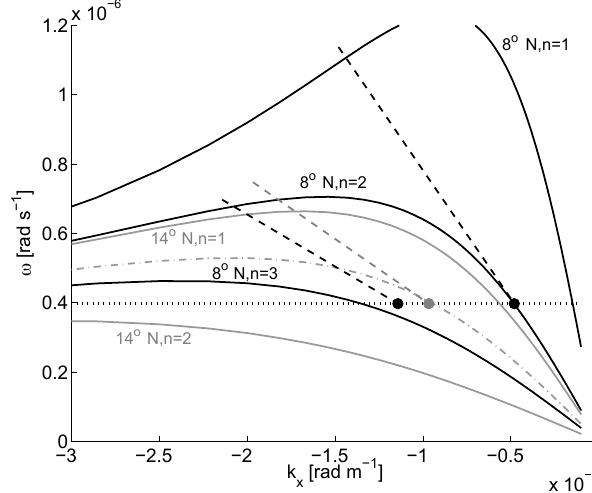
Figure 14. Wavenumber–frequency dispersion diagram for baro- clinic Rossby waves corresponding to values of the deformation radius equal to 112, 64, and 42km (solid black, baroclinic modes 1–3 at 8 ◦ N) and 59 and 31km (solid gray, baroclinic modes 1 and 2 at 14 ◦ N). The black (gray) filled dots and dashed lines represent the Rossby wave characteristics identified in Fig. 8 for TROP025: ω = 2 π /(6 months); k TROP = 2 π/λ TROP and c TROP as listed in Ta- ble 2. The gray dash-dotted line is the dispersion curve that passes through the Rossby wave mode identified at 14 ◦ N in TROP025. Its associated deformation radius is 48km, i.e., significantly less than the actual baroclinic mode 1 deformation radius at that latitude (59km). The horizontal dotted line corresponds to the semiannual